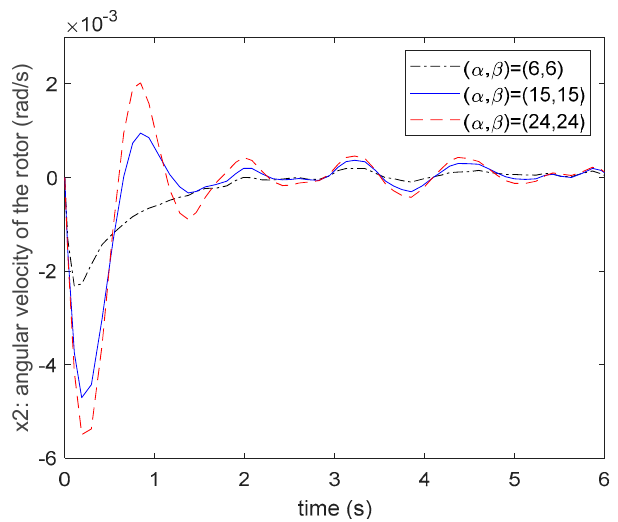
Figure 10. The comparisons of state x 2 ( t ) responses for different circle regions.